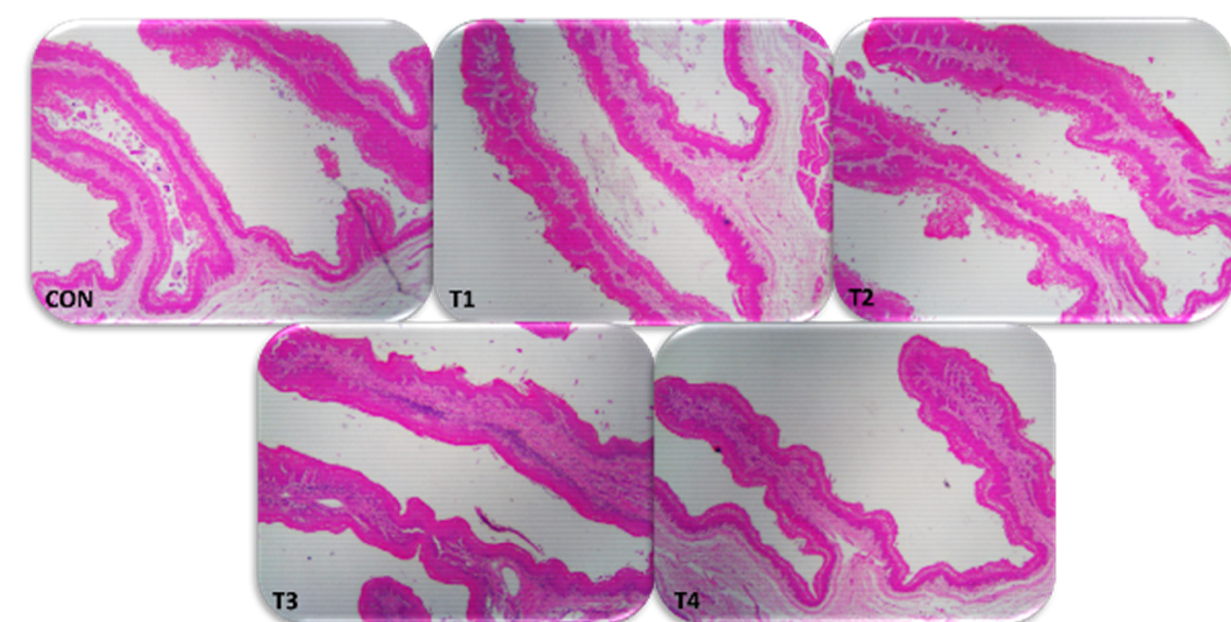
Figure 2. Photomicrographs to histomorphometric for rumen sections of growing lambs stained with hematoxylin and eosin (20×). CON = traditional diet 100% (Barley 70%: Alfalfa hay 30%); T1 = traditional diet 75%: sprouted barley 25%; T2 = traditional diet 50%: sprouted barley 50%; T3 = traditional diet 25%: sprouted barley 75% and T4 = sprouted barley